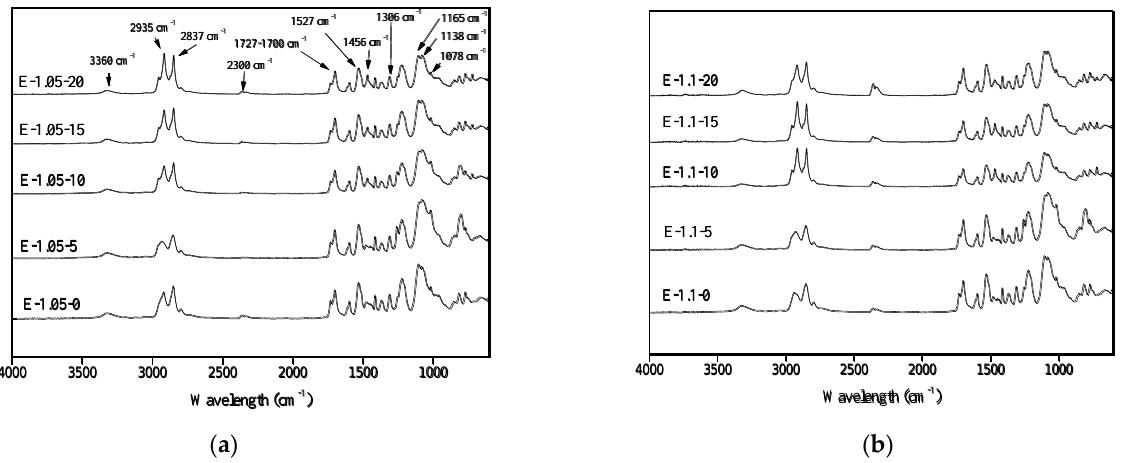
Figure 1. Appearance of the synthesized elastomers with different [NCO]/[OH] and mSD-(LDPE · EVA-RT27) contents.